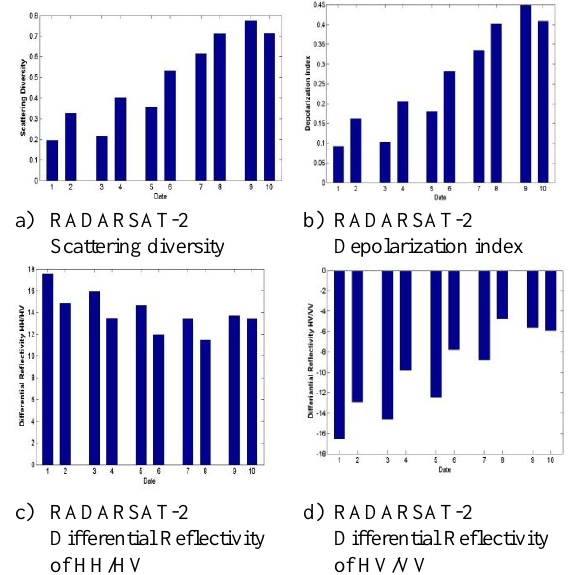
Figure 5. Additional RADARSAT-2 polarimetric parameters of canola crop type. Date in X-axis is from April 16 to July 31 for RADARSAT-2 as shown in Table 1